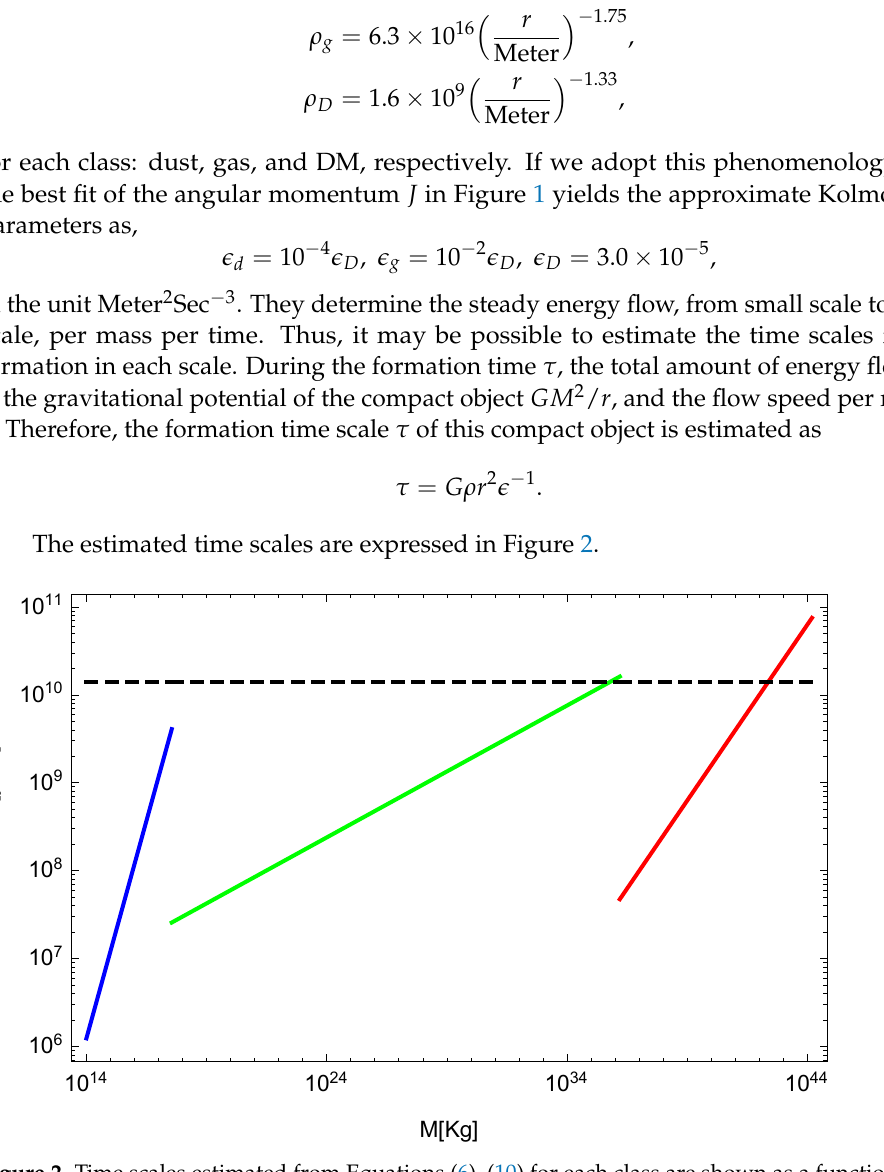
Figure 2. Time scales estimated from Equations (6)–(10) for each class are shown as a function of the mass M of the astronomical object. The color blue, green, and red reflects each class and corresponds to the fitting color in Figure 1. The dashed line represents the age of the Universe at present for comparison. Although the structure formation will dominantly take place at the smallest scale in each class, there may take place some formation process at the intermediate scales in the steady flow of energy. The estimate in this figure should not be taken too seriously since the Universe is not steady, in particular at larger scales. Actually, the estimated time scale well exceeds the age of the Universe in those